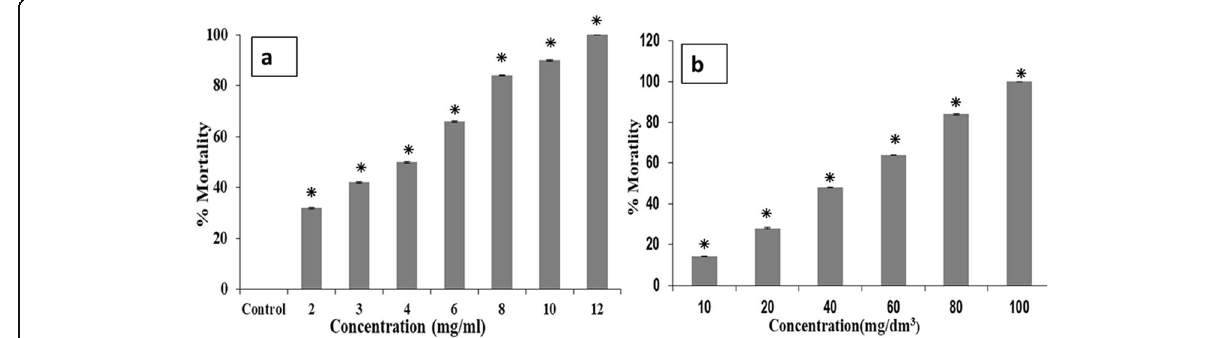
Fig. 1 Bioefficacy of bay essential oil against M. domestica . a Percent mortality of larvae after a treatment of 24 h. b Adulticidal activity of the tested EO against newly emerged M. domestica after 24-h treatment. LC 50 and LC 90 are lethal concentrations at which 50% and 90% population dies, respectively. Each value represents the mean of five replicates. Asterisk indicates significance at p <